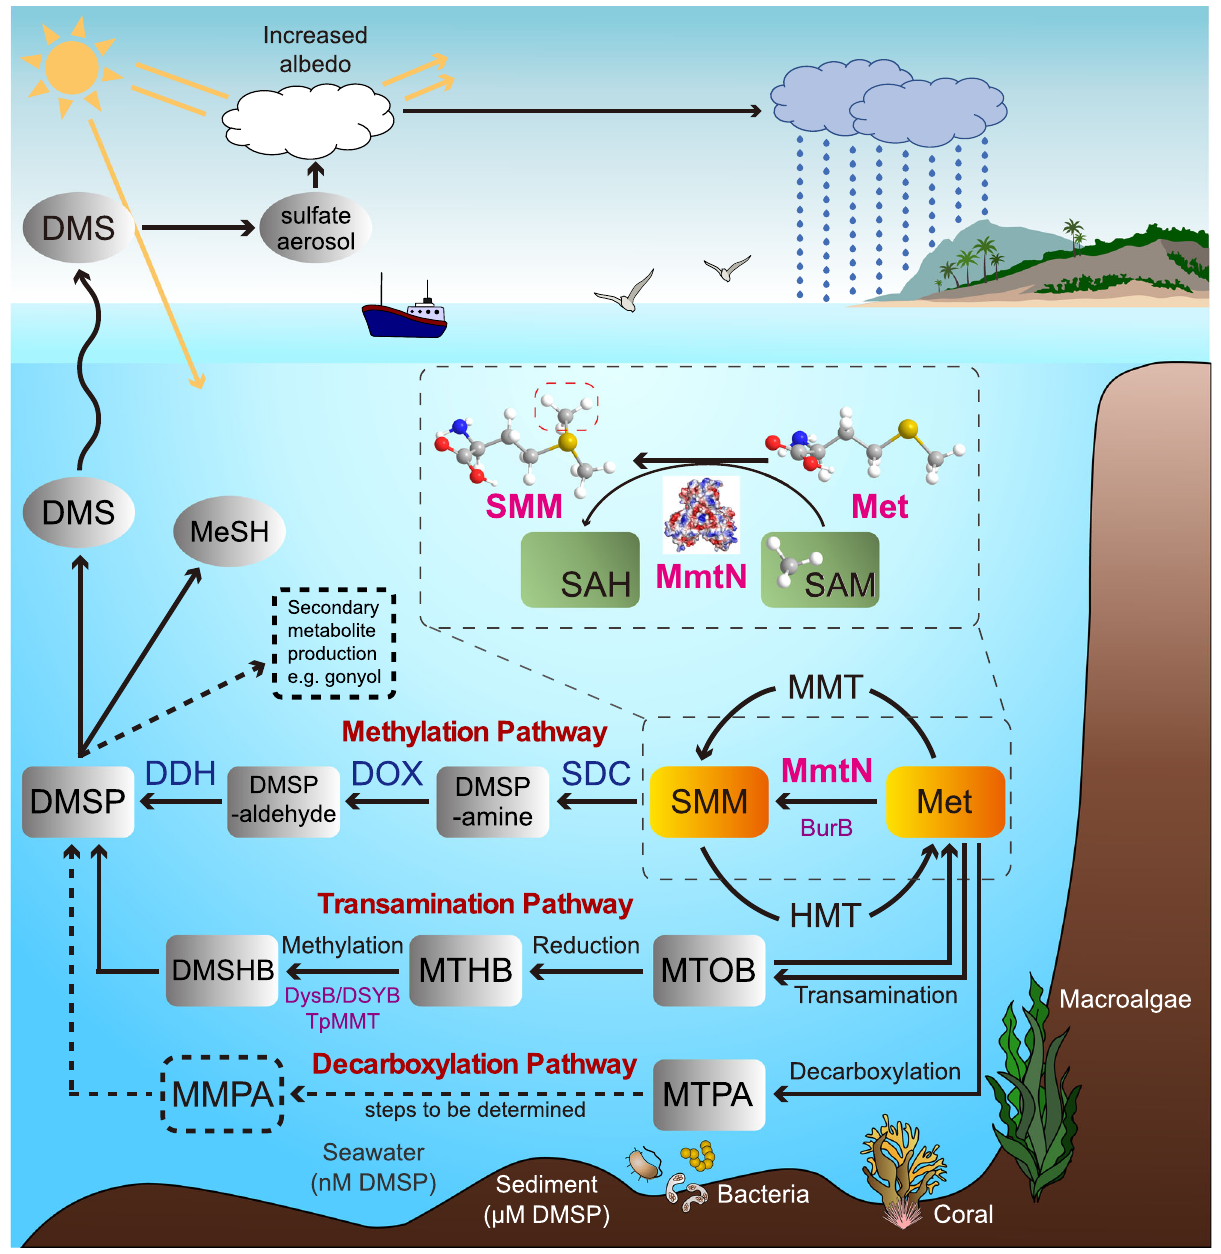
Fig. 1 DMSP-biosynthesis pathways in the marine ecosystem. The DMSP synthesis pathways, with emphasis on the methylation pathway and in particular the S -methylation of Met to SMM, catalyzed by MmtN (bacteria) or MMT (plants). This step is marked by grey dotted boxes. Dotted black lines represent the uncon fi rmed steps of the decarboxylation pathway, and a potential but uncon fi rmed role for DMSP in secondary metabolite production. S -methyltransferase enzymes of the transamination pathway for DMSP synthesis and methylation pathway in Burkholderia are indicated in purple font. SMM, S -methylmethionine; MTOB, 4-methylthio-2-oxobutyrate; MTHB, 4-methylthio-2-hydroxybutyrate; MTPA, 3-methylthiopropylamine; DMSHB, 4-dimethylsulfonio-2-hydroxybutyrate; MMPA, methylmercaptopropionate; DMSOB, 4-dimethylsulfonio-2-oxobutyrate; MMT, Met S -methyltransferase; HMT, homocysteine S -methyltransferase; SDC, SMM decarboxylase; DOX, DMSP-amine oxidase; DDH, DMSP-aldehyde dehydrogenase.